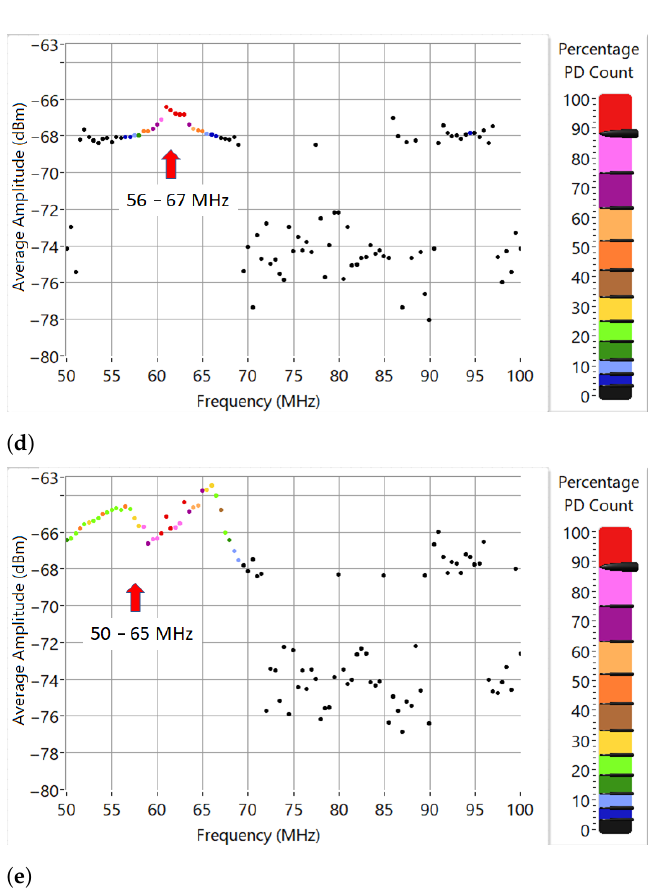
Figure 16. FRPD for different cases, from 50 to 100 MHz: ( a ) corona, ( b ) slot, ( c ) corona with slot, ( d ) noise with the power supply not energized, and ( e ) noise with energized power supply. FRPDs obtained from 100 to 150 MHz are shown in Figure 17. High counting noise is not seen in Figure 17d,e. Figure 17a shows corona PDs between 124 and 137 MHz, with PD counts up to 12% and amplitudes that reach − 65.5 dBm, as the blue arrow indicates. Slot PDs are seen between 125 and 133 MHz in Figure 17b, with PD counts up to 25% and amplitudes reaching − 67 dBm, as the green arrow points out. Figure 17c shows coronas with slot PDs between 125 and 135 MHz with PD counts up to 33%. In this case, since the corona’s and slot’s high counting bands completely intercept each other, it is difficult to distinguish the phenomena by inspecting exclusively the 100–150 MHz band. A very similar situation is seen by inspecting the 150–200 MHz range. As Figure 18a,b show, corona and slot high counting bands are completely superimposed on each other, making discrimination of patterns an intricate process when inspecting Figure